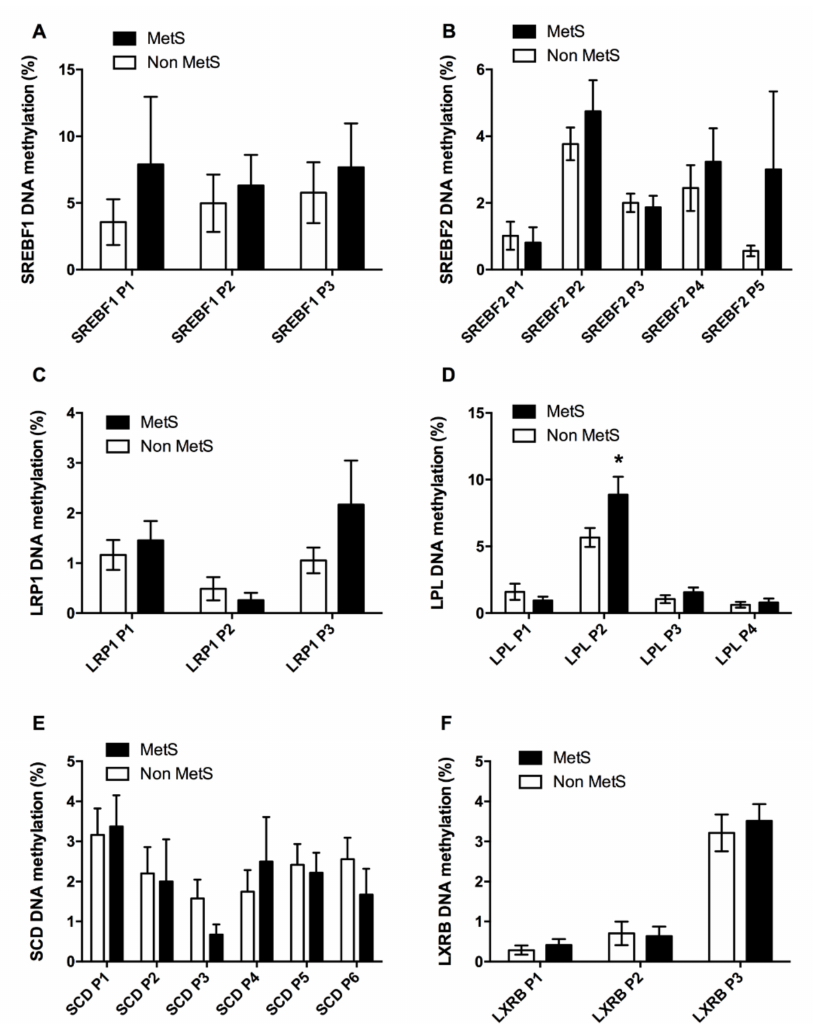
Figure 3. Lipid metabolism DNA methylation. The figure shows the DNA methylation in Non MetS and MetS groups at each CpG for several factors related to lipid metabolism as SREBF1 ( A ), SREBF2 ( B ), LRP1 ( C ), LPL ( D ), SCD ( E ), and LXRB ( F ). Values are given as the mean ± SE. Sterol regulatory element binding transcription factor 1 (SREBF1); Sterol regulatory element binding transcription factor 2 (SREBF2); low density lipoprotein receptor-related protein 1 (LRP1); lipoprotein lipase (LPL); Stearoyl-CoA desaturase (SCD); liver X receptor beta (LXRB). * means p < 0.05 according to a Student’s T